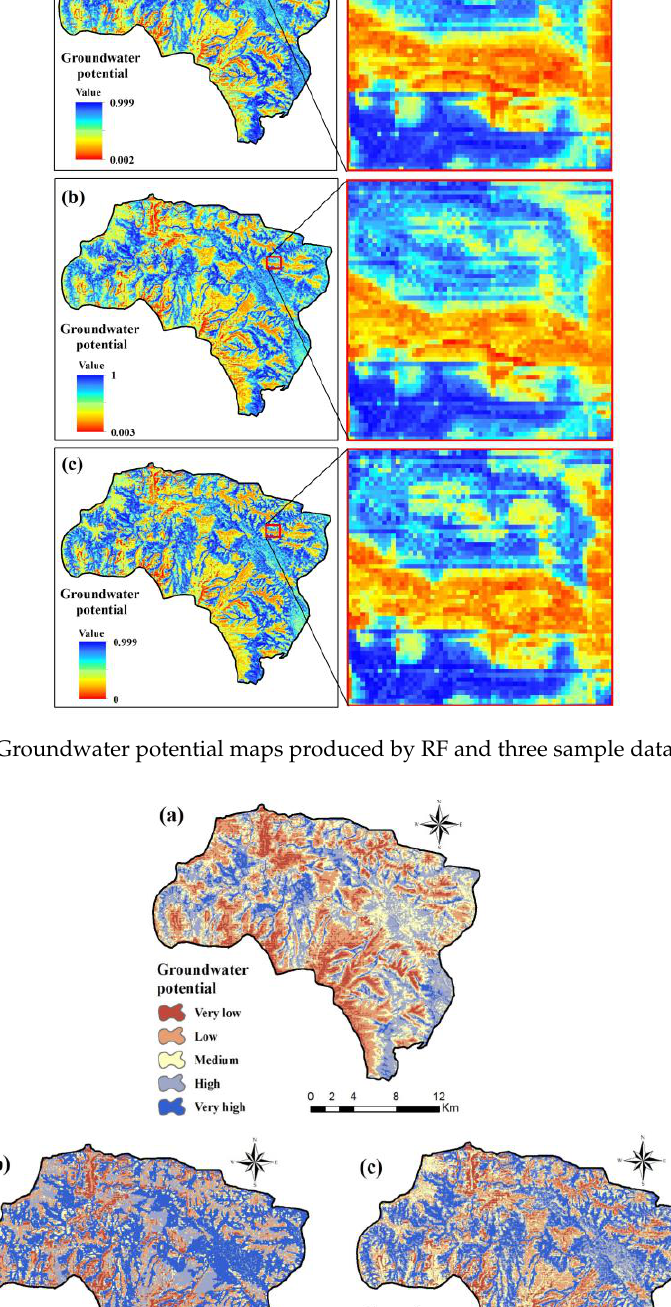
Figure 6. Groundwater potential maps produced by QUEST and three sample datasets ( a – c ).